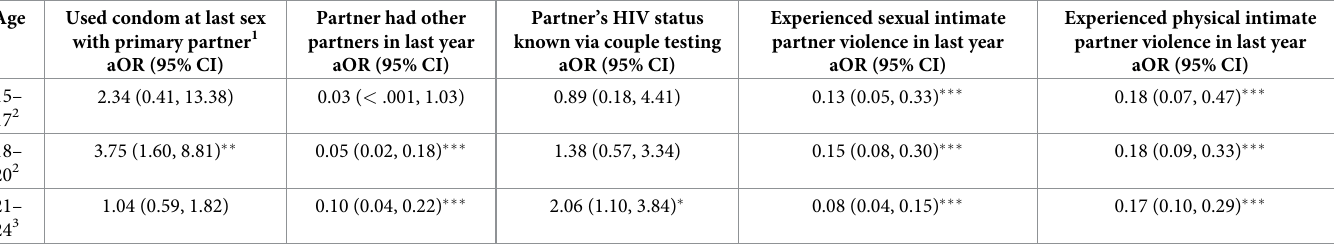
Table 5. Adjusted odds ratios for HIV and partner violence outcomes on Sexual Relationship Power Scale (SRPS) scores, stratified by AGYW age